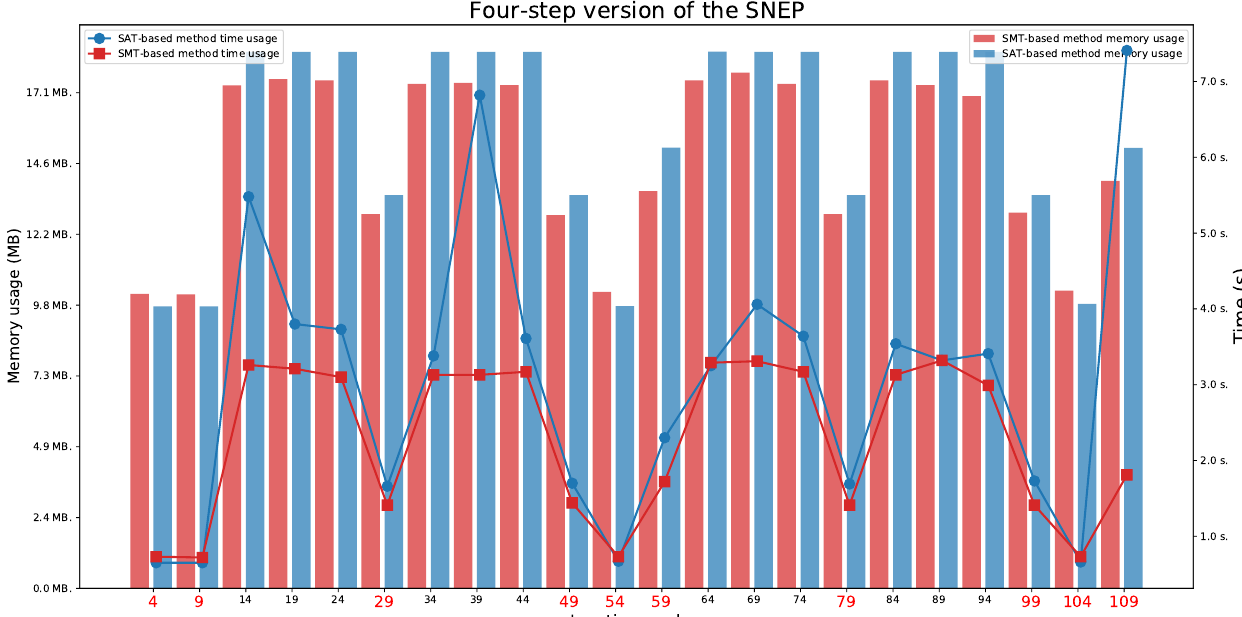
Figure 12. The four-step version of the SNEP: Time and memory usage for checking the last locations’ reachability in each execution automaton for the lifetime value equal to 7. The reachable states are marked in